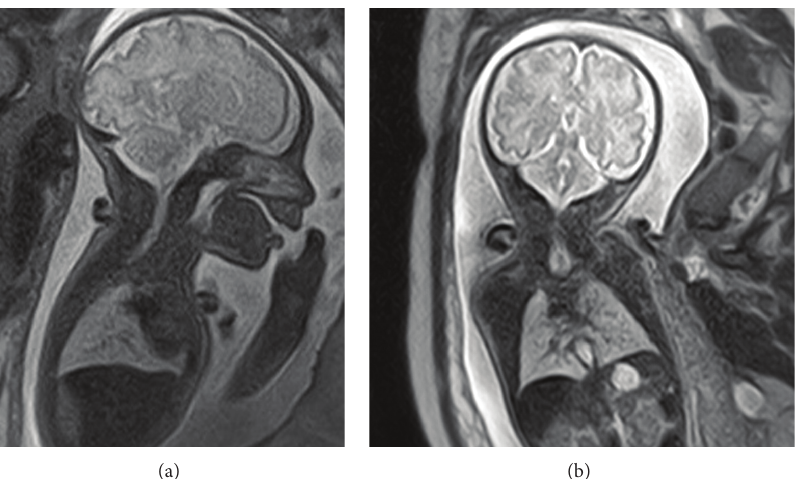
Figure 1: Case report: fetal MRI. Saggittal (a) and axial (b) view. Absence of continuity between subglottic area and bronchial bifurcation: Floyd’s classification of type